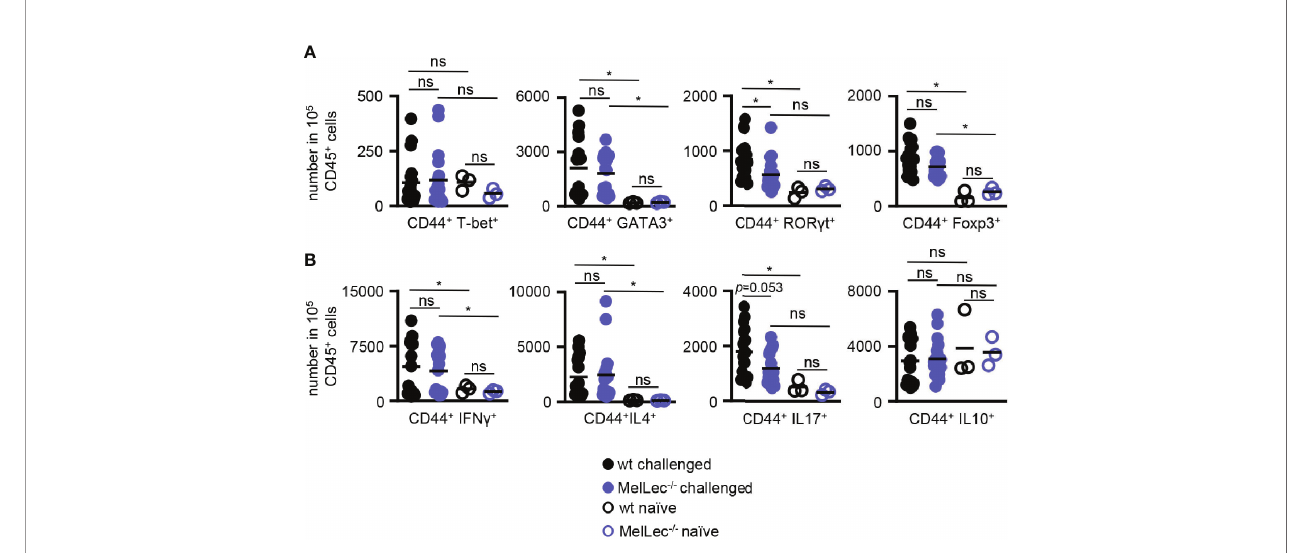
FIGURE 5 | Altered T-cell responses in MelLec-de fi cient mice. Flow cytometric analysis of T-cell expressed (A) transcription factors and (B) cytokines, as indicated, in the lungs of wild type (wt) and MelLec -/- mice on day 23 following sensitization and challenge with live Aspergillus fumigatus conidia. CD44 + CD4 + T cells expressing transcription factors or cytokines are expressed as numbers per 1x10 5 CD45 + cells. Shown are pooled data (with mean) from at least two independent experiments (n>15 mice). Data from unchallenged naïve mice are also shown (n=3). *p<0.05. n.s., not signi fi cant. Statistical signi fi cance was determined using ANOVA.